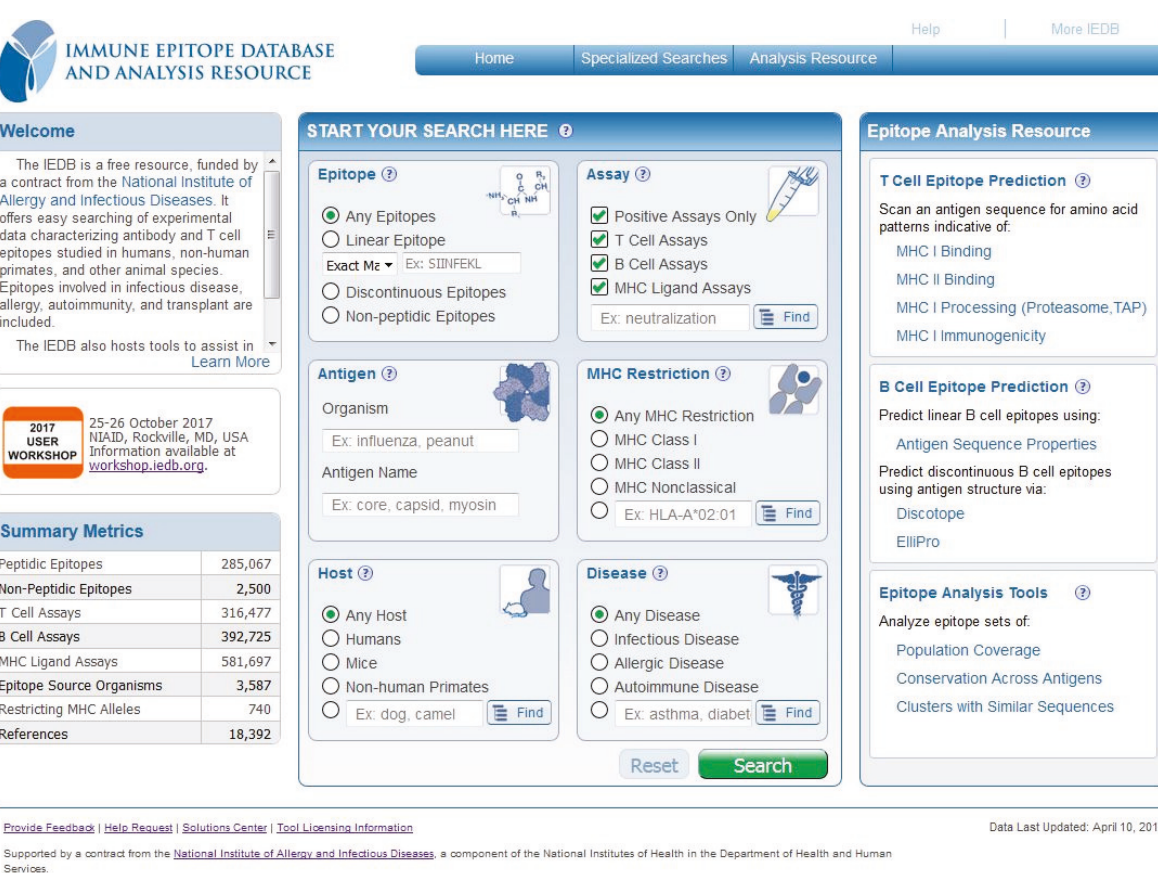
Figure 2: The IEDB home page features a search interface in the center of the